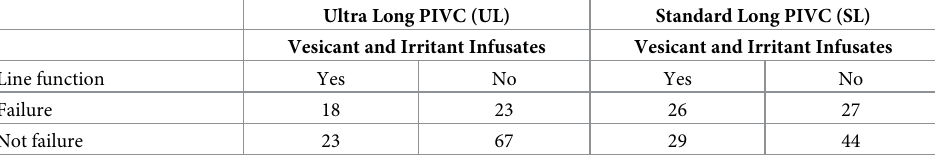
Table 2. Summary on intravenous line